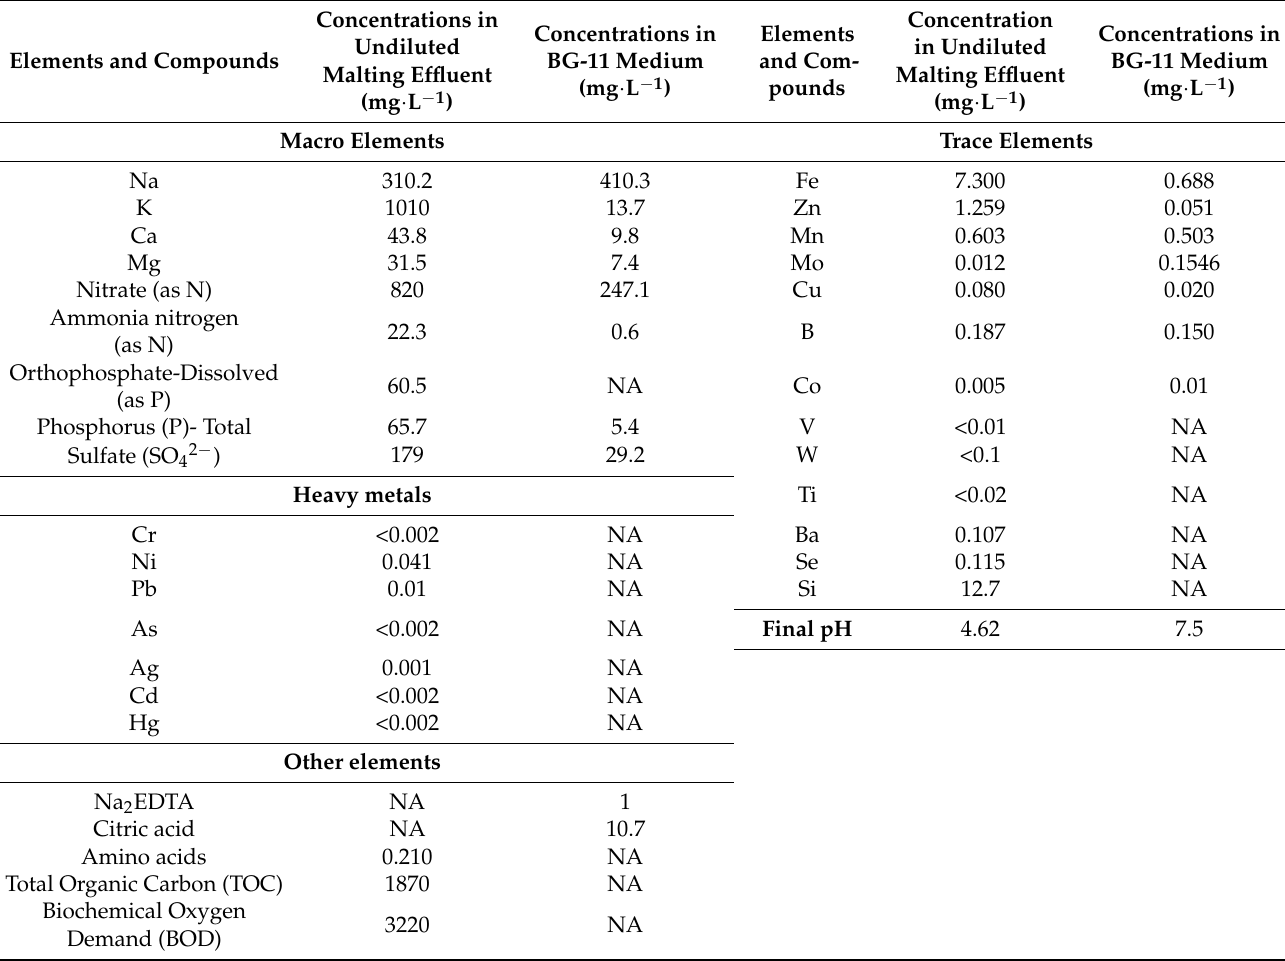
Table 1. Comparison of elements and compounds between undiluted malting effluents and standard mineral media (BG-11) for growth of